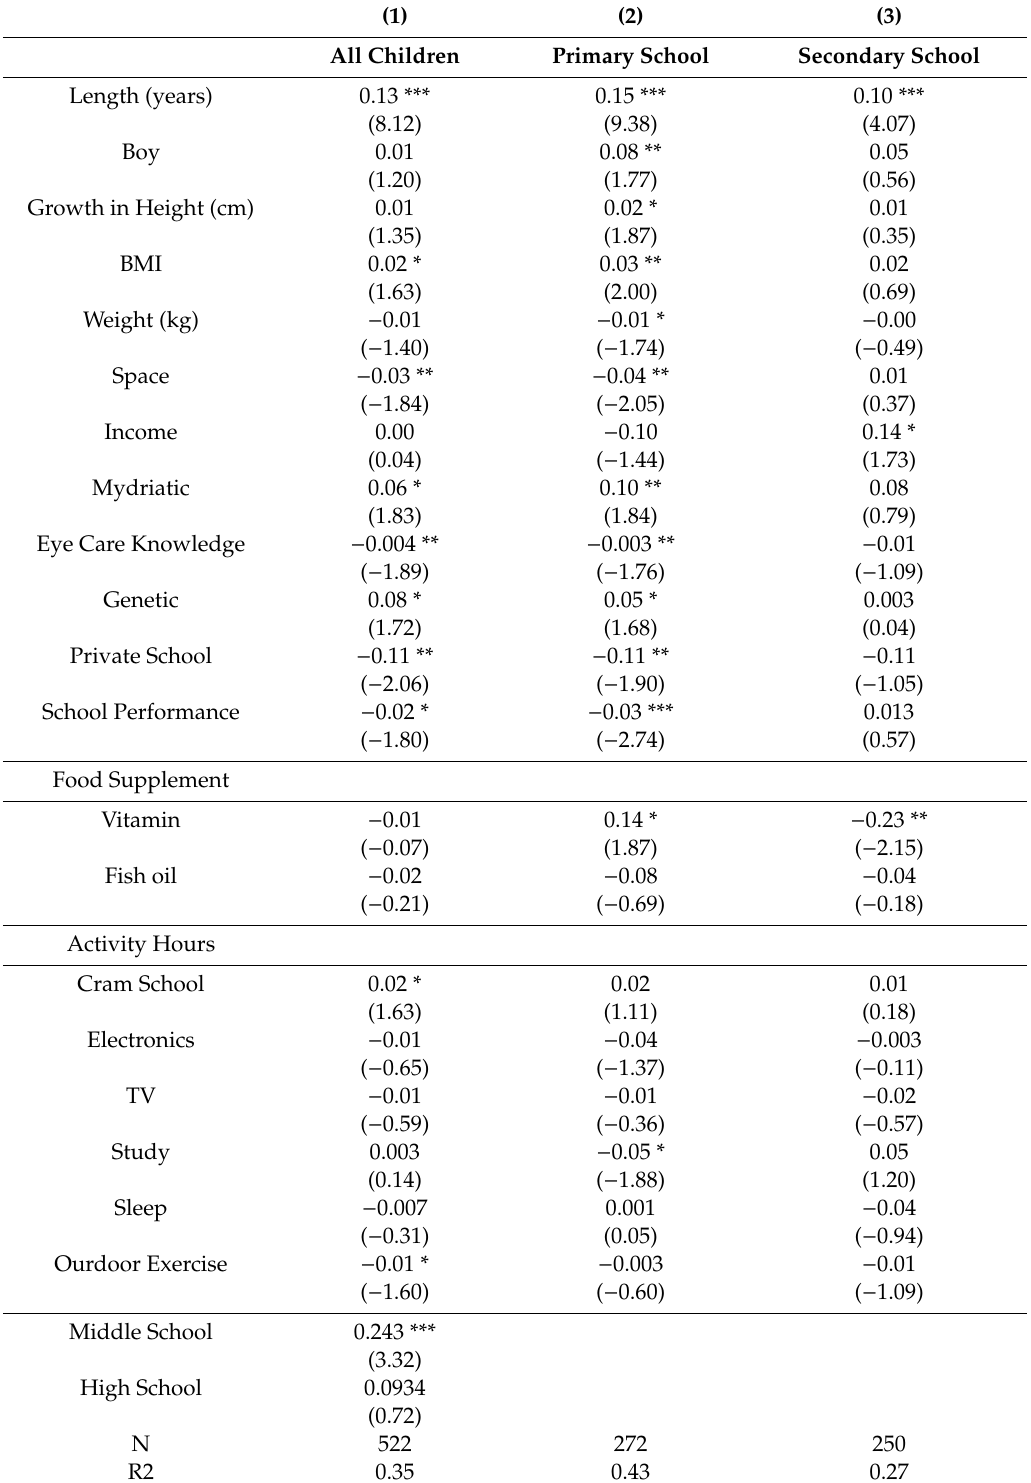
Table 4. Regression analysis of factors that explain the severity in myopia †